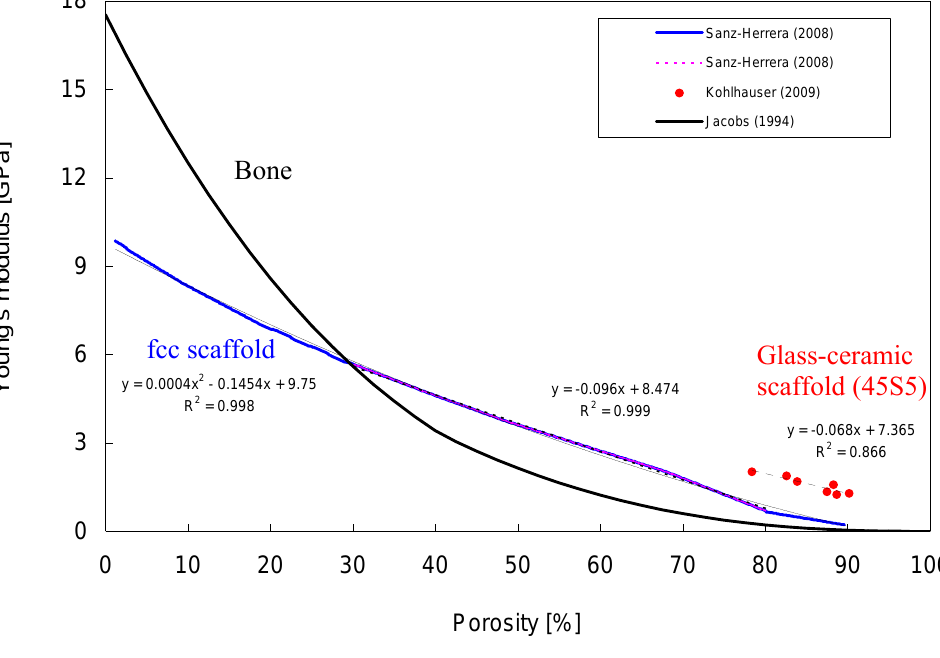
Figure 9. Young’s modulus of an fcc scaffold microstructure [141] and of bone [139] as a function of porosity (Data kindly provided by Prof. J. A. Sanz-Herrera, University of Seville, Spain). The pink, dashed line, overlapping the blue line, represents the data range (porosity of fcc structure = 30–80%), in which a highly linear relationship between porosity and Young’s modulus exists. A second order polynomial function describes the Young’s modulus of the fcc structure over the entire range of investigated porosities (1.2–89.6%). For Bioglass ® -based glass-ceramic scaffolds (data adapted from ref. [112]), a highly linear negative correlation (coefficient of determination R 2 = 0.866) between porosity and elastic modulus was found on the basis of ultrasonic wave propagation